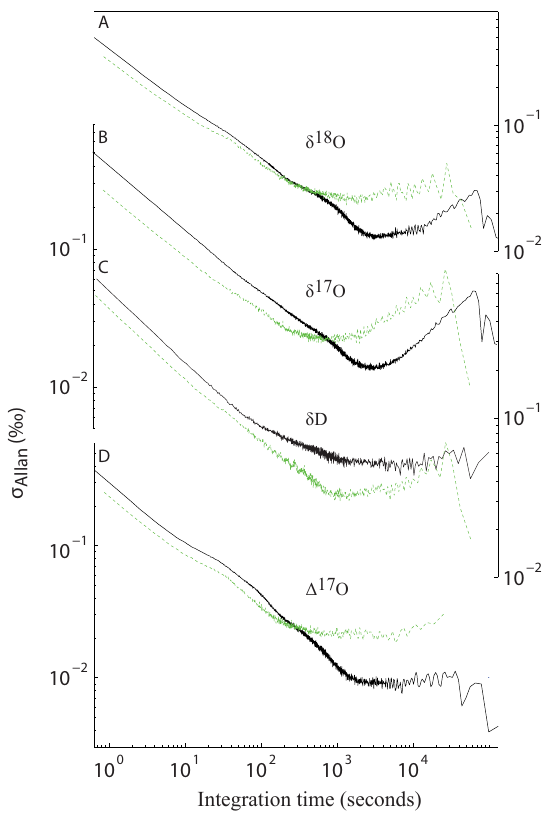
Figure 3. Comparison of Allan deviations for water isotope ratios with the L2130- i -C using a conventional wavelength monitor and spectral peak amplitude (green dashed lines), and with the L2140- i using laser-current-tuned cavity resonance and integrated absorp- tion (solid lines). (A) δ 18 O, (B) δ 17 O, (C) δ D, (D) 1 17 O.